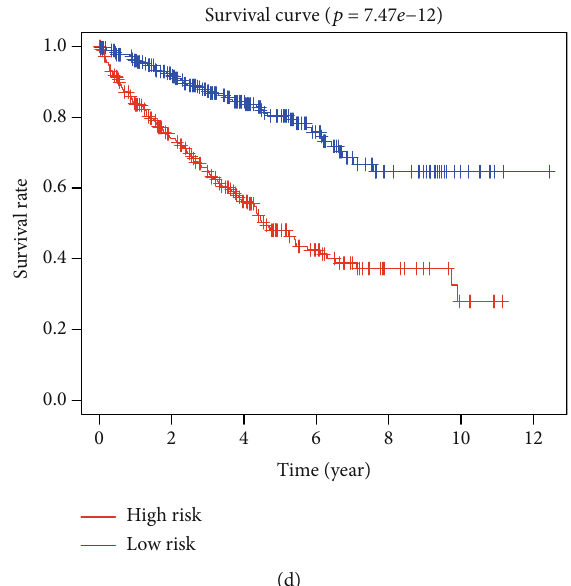
Figure 5: Risk signature for ccRCC. (a) Hazard ratios (HRs) and 95% con fi dence intervals (CIs) were calculated using univariate Cox regression. (b, c) Coe ffi cients calculated by the least absolute shrinkage and selection operator (LASSO) multivariate Cox regression algorithm. (d) Kaplan-Meier overall survival (OS) rate curve for high-risk (red) and low-risk (blue) groups of